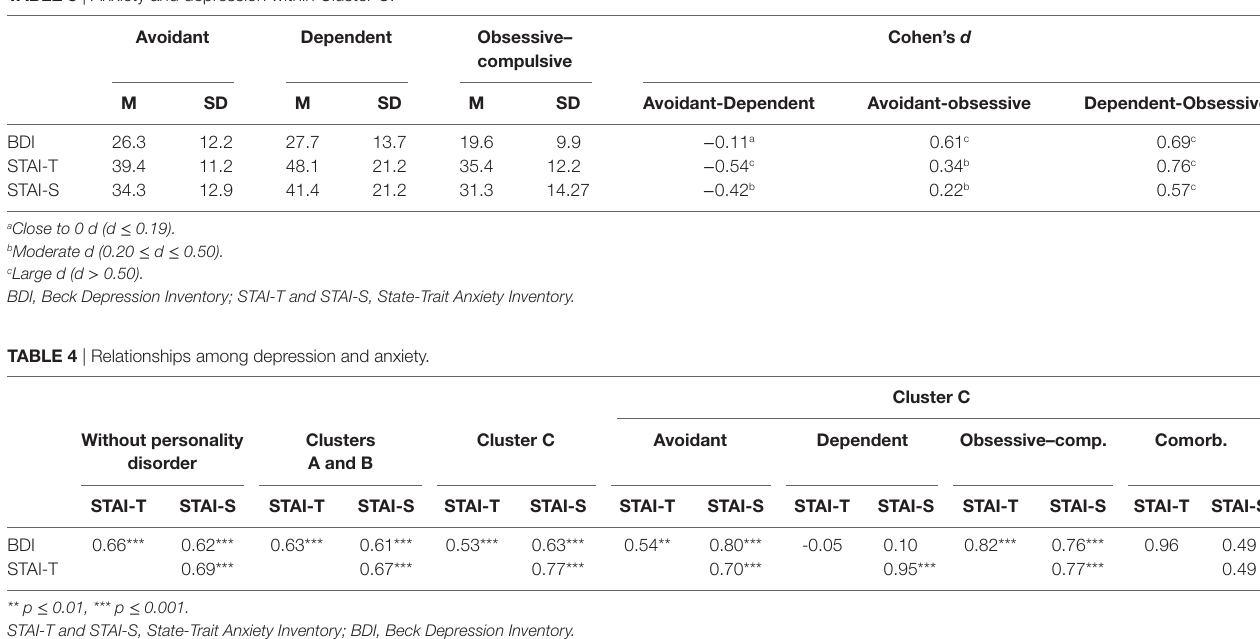
Table 3 | Anxiety and depression within Cluster C. avoidant Dependent Obsessive– cohen’s d compulsive sD avoidant-Dependent avoidant-obsessive Dependent-Obsessive